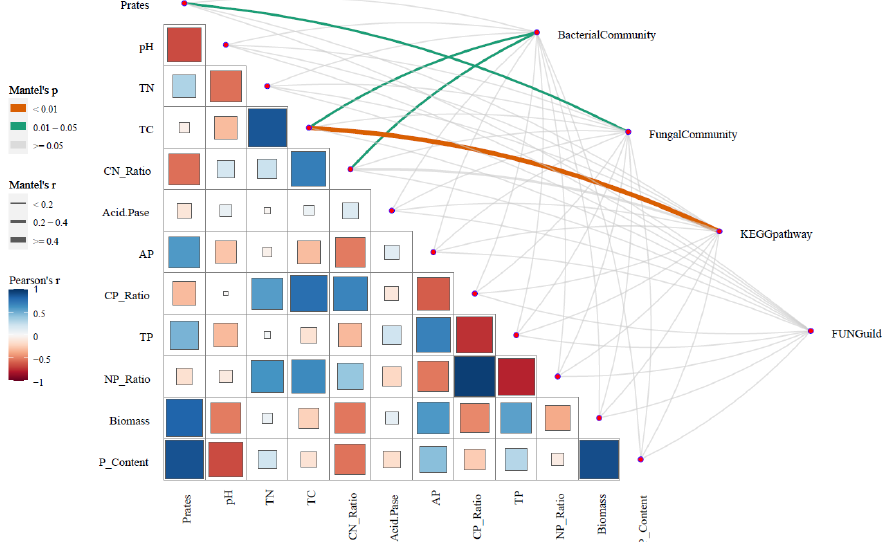
Figure 3. Correlation analysis of various environmental factors with soil microbial structure and function. Prates indicates the Rate of Phosphate fertilizer application and Acid.Pase indicates Soil Acid Phosphatase (ACP). Bacterial Community and Fungal Community were calculated by the data of PCoA axis1. In the Mantel test, red represents p < 0.01, green means 0.01 < p < 0.05, and coarseness represents the size of correlation coefficient. Pearson correlation coefficients were shown in different colors.